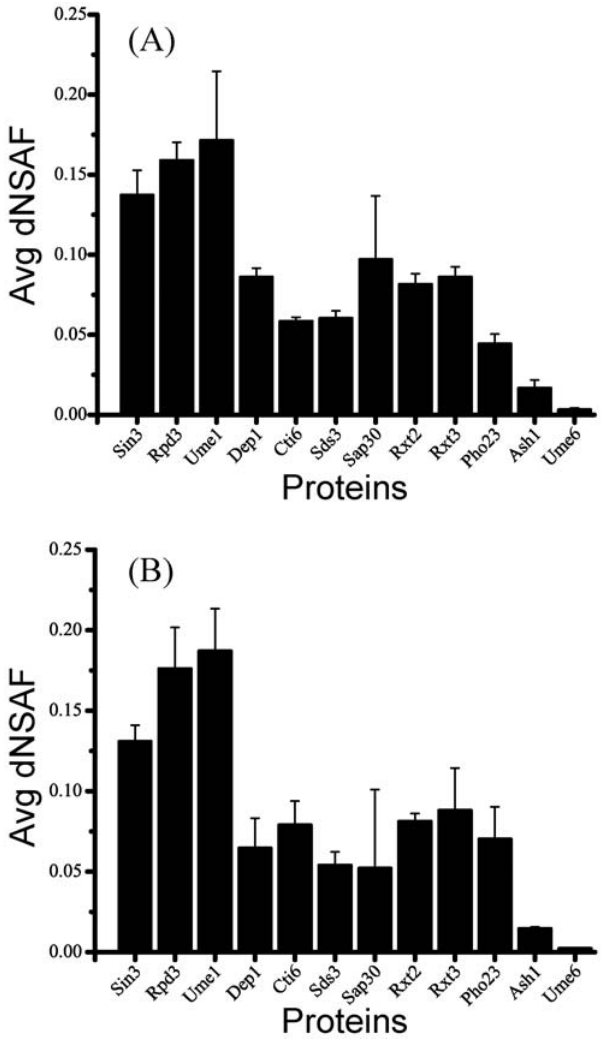
Figure 2. Relative abundances of Rpd3/Sin3 components. For visualization purposes, the components of the Rpd3/Sin3 complexes were represented using (A) Pho23-TAP, and (B) Sap30-TAP, MudPIT analysis was performed on three replicates for each of the purification and the observed dNSAF values for each subunit averaged. Error bars are shown and represent one standard deviation of the data.